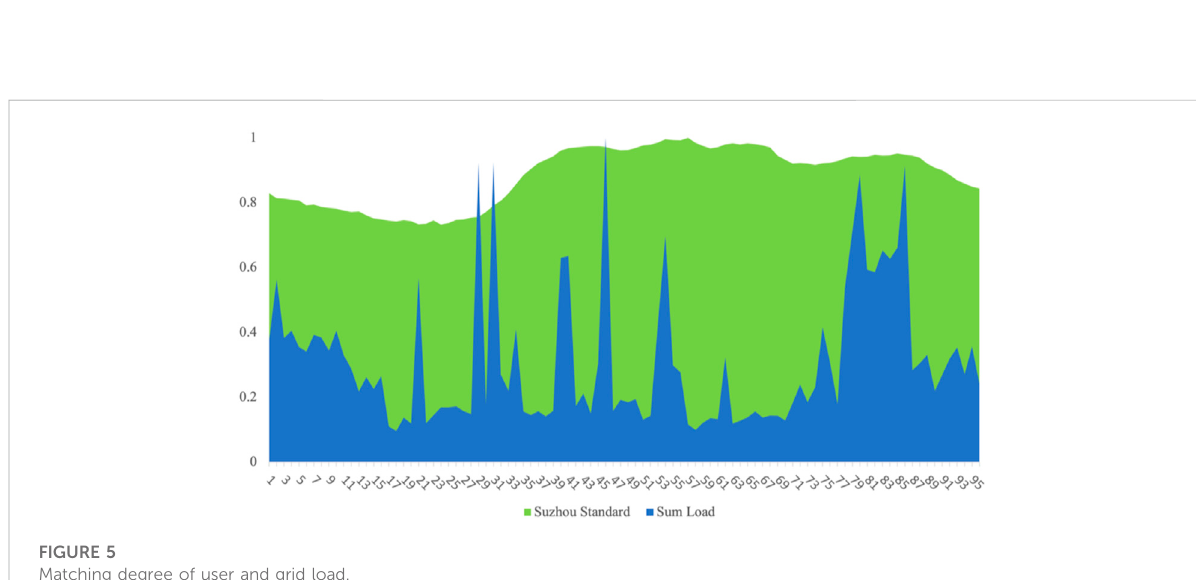
FIGURE 5 Matching degree of user and grid